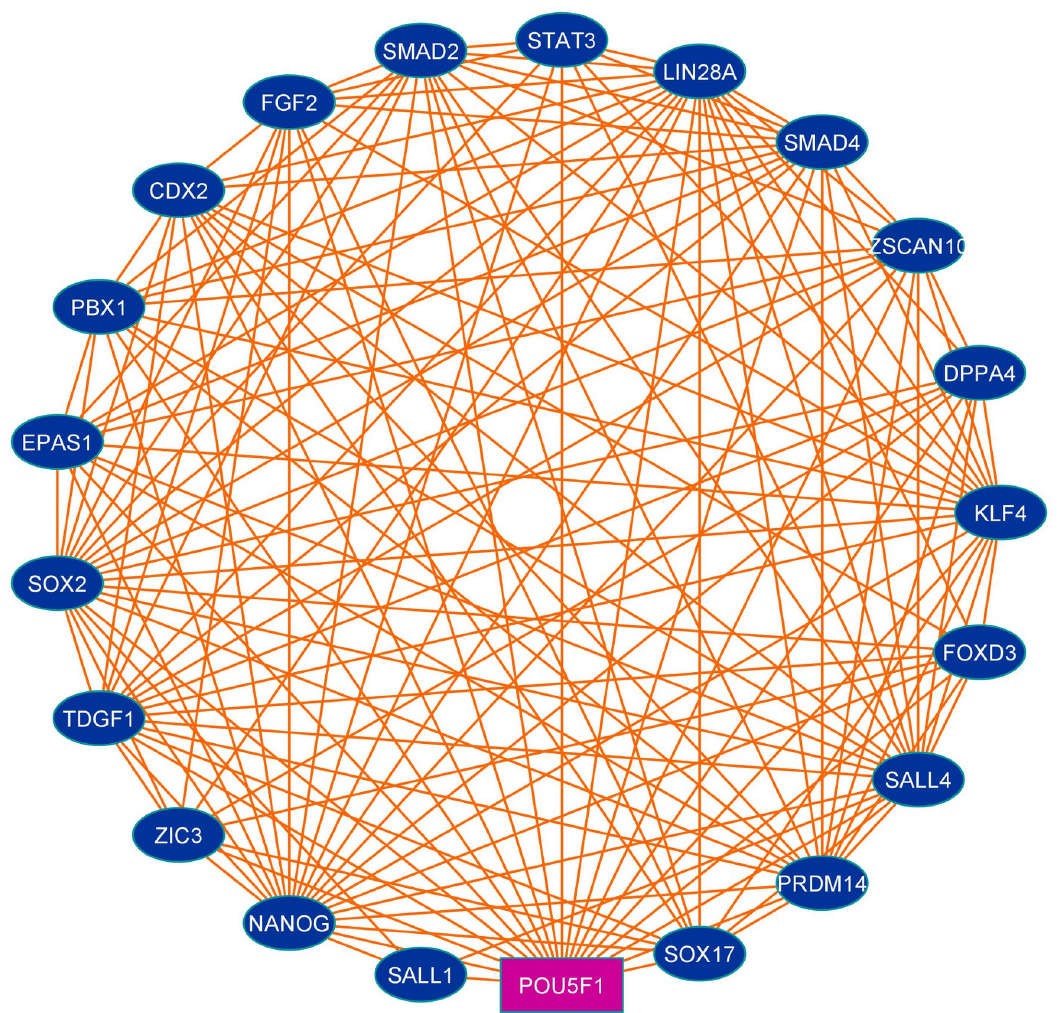
Fig 2. Protein-protein interaction map of Oct4 generated using online tool STRING. The pink colored rectangular node represents the query protein (Oct4).